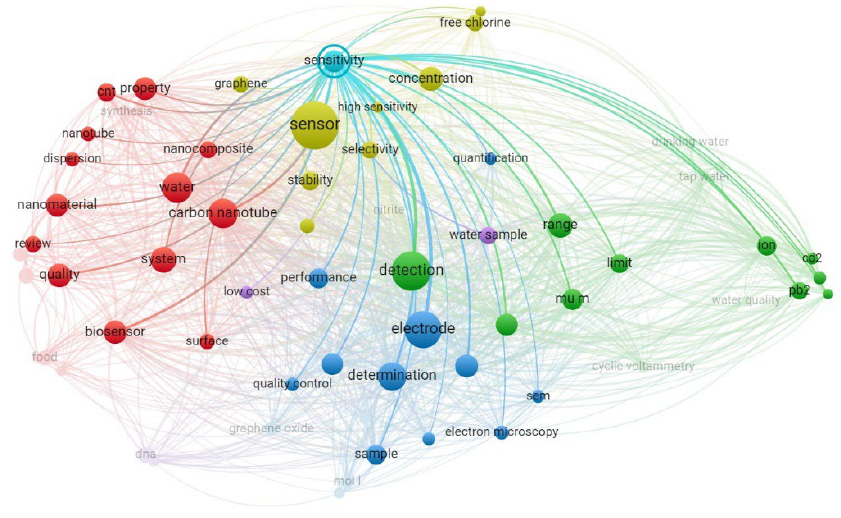
Figure 10. Cluster 6 Network—“sensitivity” main keyword.